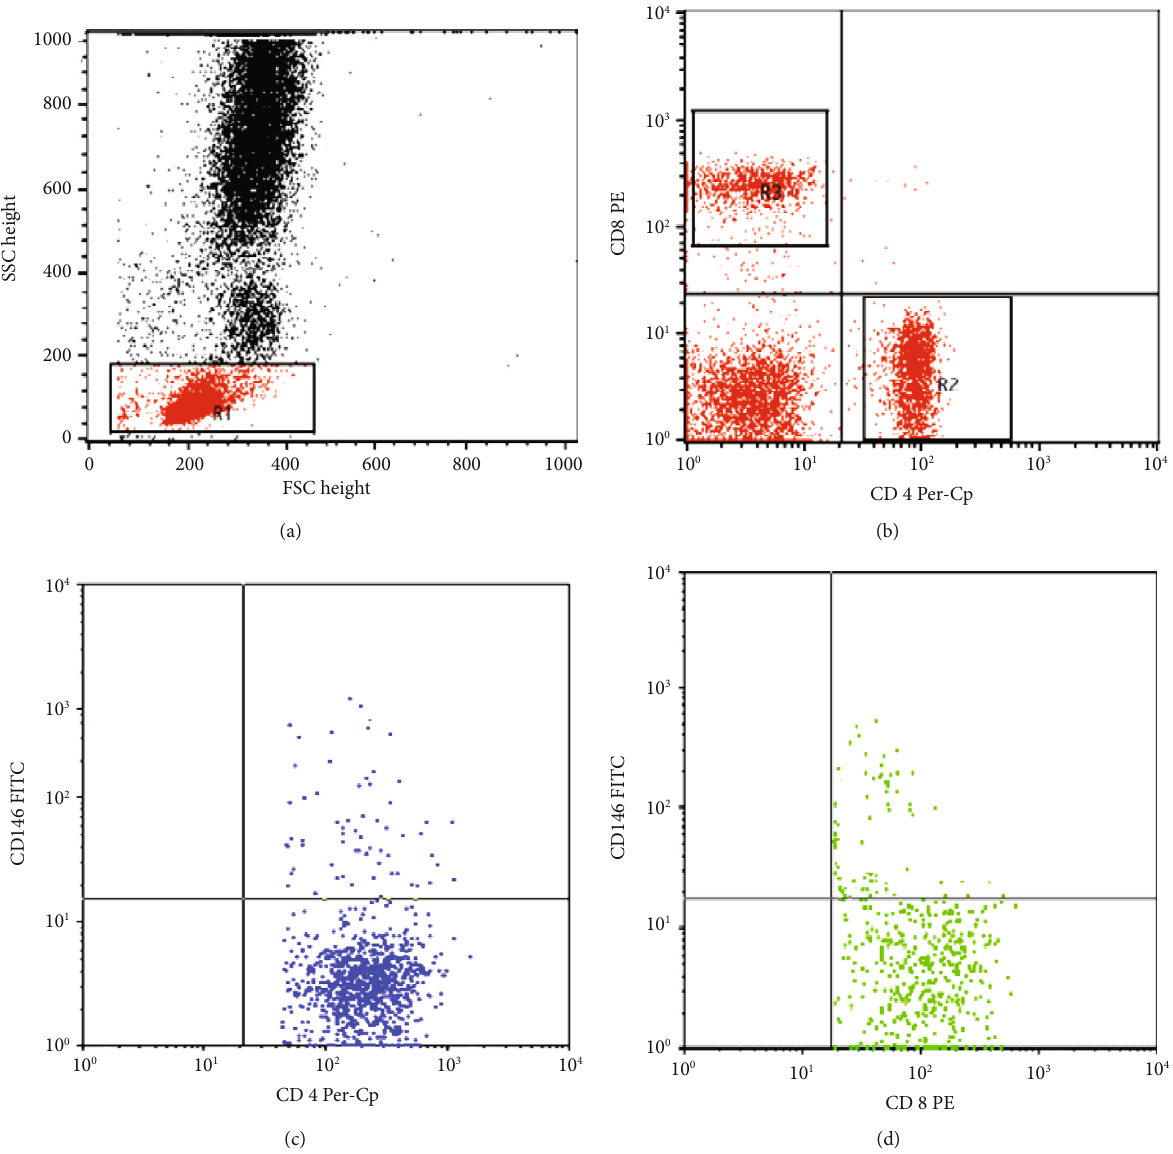
Figure 1: Flow cytometric detection of the CD146 expression on peripheral blood T cells. (a) Forward and side scatter histogram was used to de fi ne the lymphocyte population (R1). (b) The expressions of CD4 and CD8 on the lymphocyte population were detected, and then, CD4 + cells and CD8 + cells were gated for further analysis of CD146. (c) The expression of CD146 on CD4 + cells. (d) The expression of CD146 on CD8 +